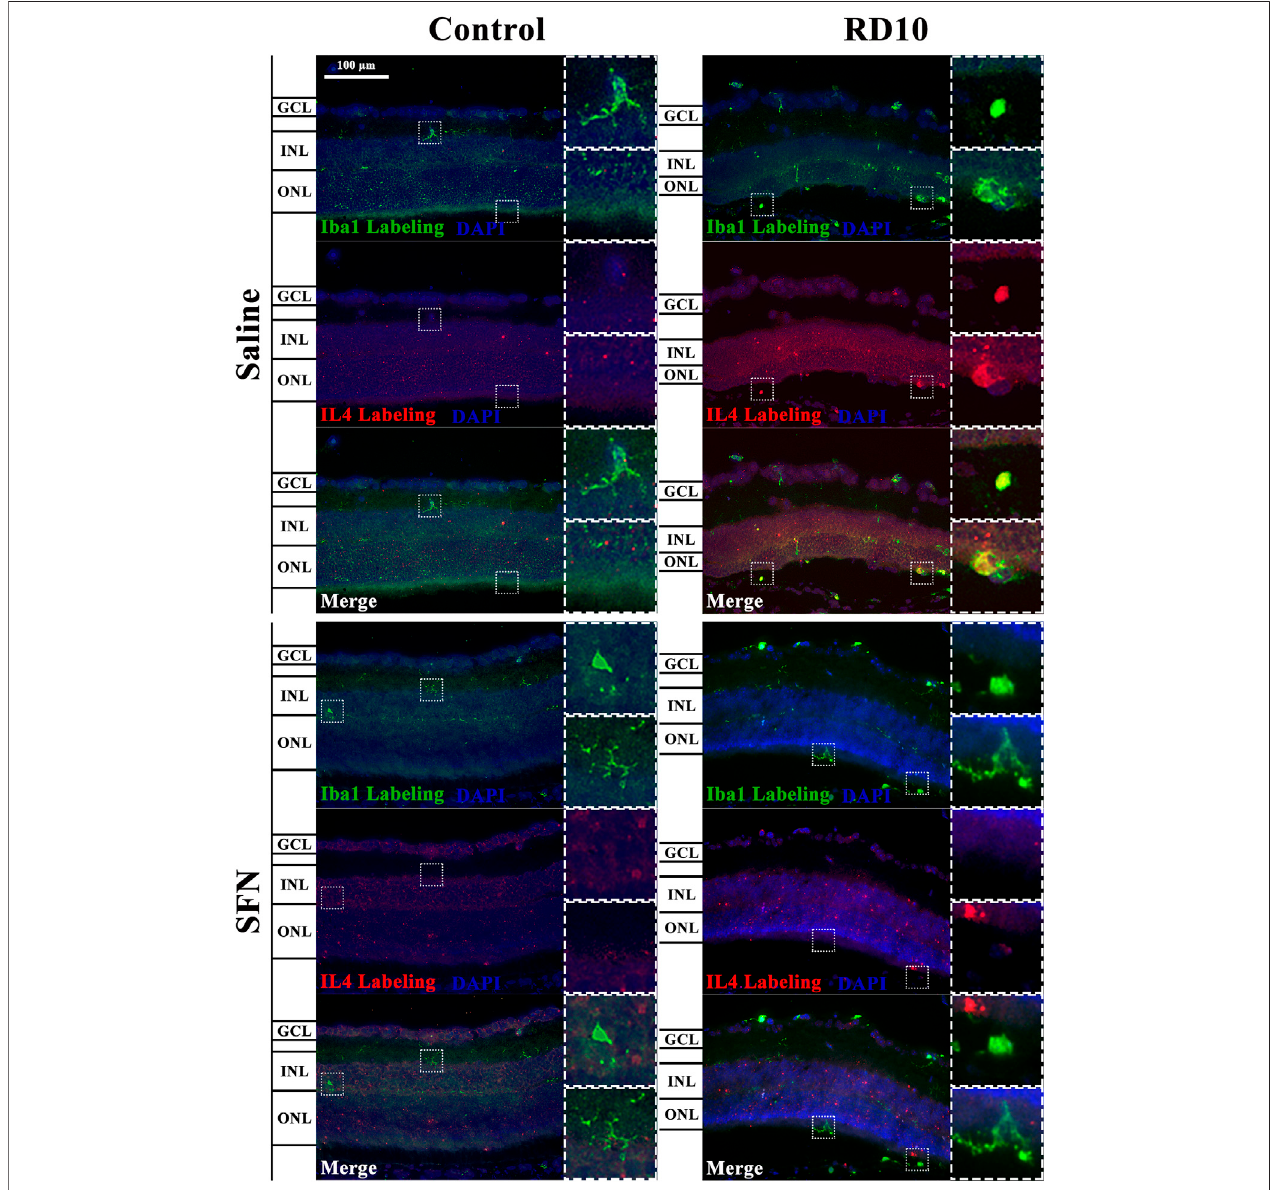
FIGURE 10 | Illustrative IL4-Iba1 immuno fl uorescent images from the nerve region of the different groups in the experiment.